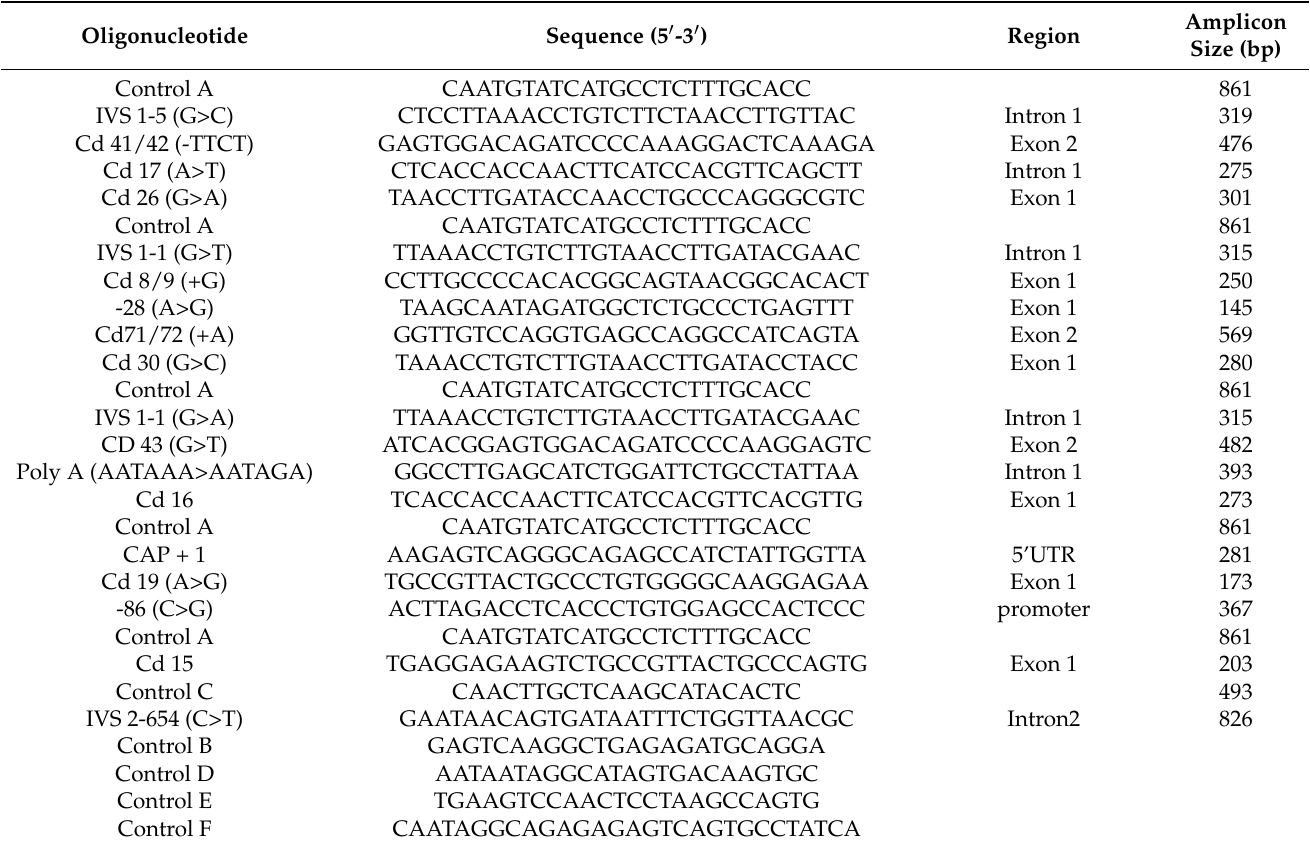
Table 1. The sequence of primers used for detecting beta-globin gene mutations by MARMS.